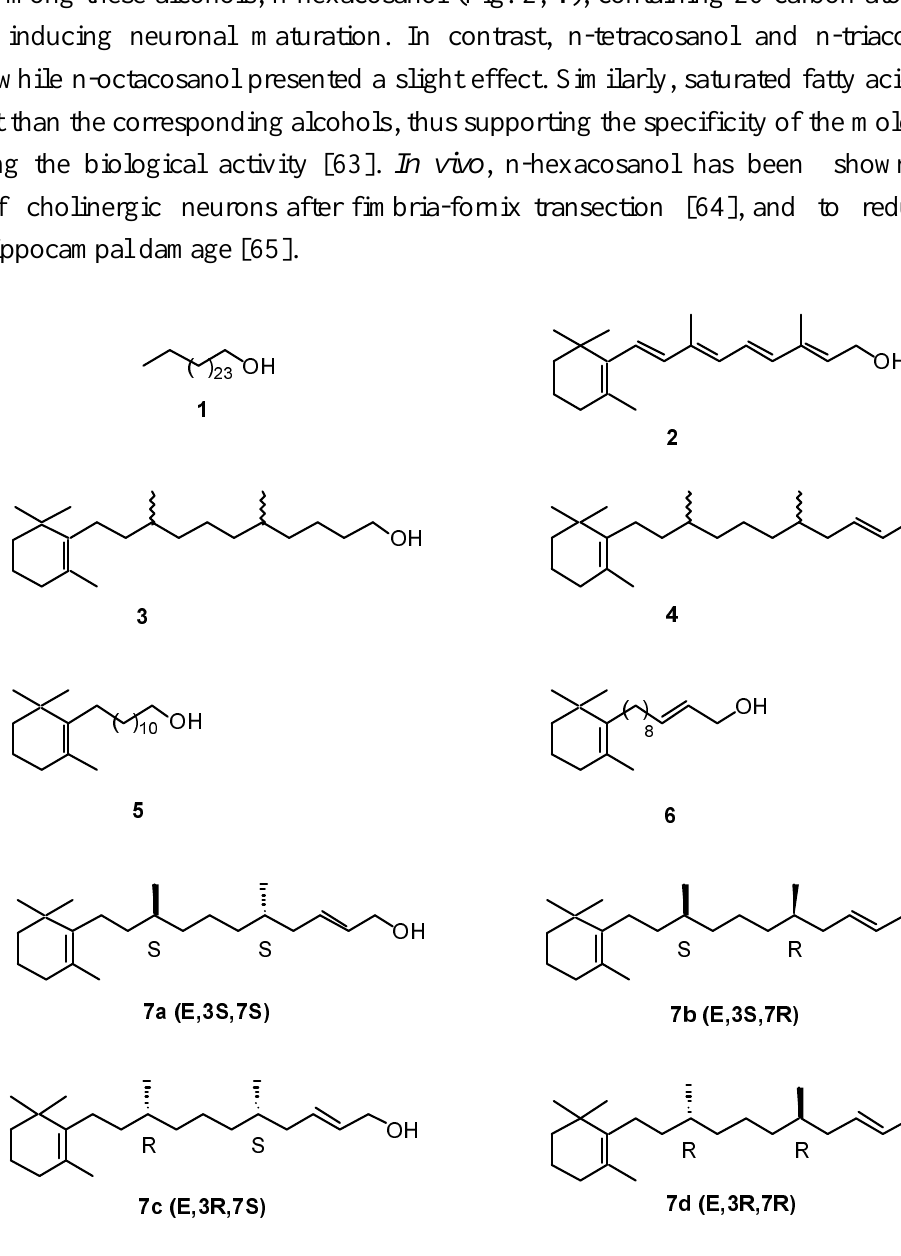
Figure 2. Structure of n-hexacosanol (1), retinol (2), and its elongated analogues